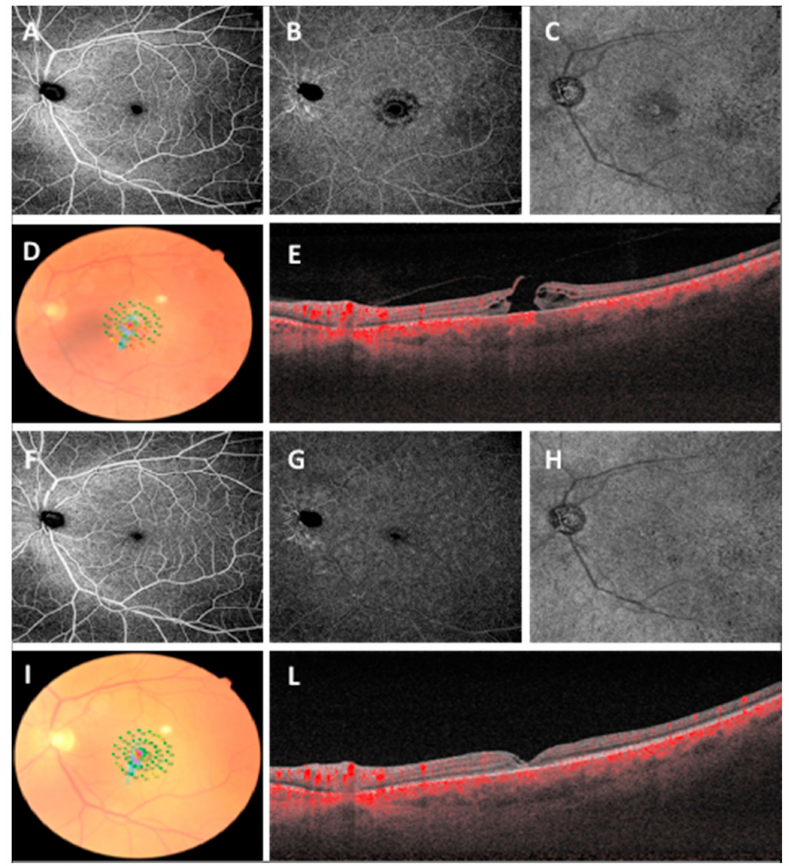
Figure 2. Widefield OCTA scans (12 × 12 mm) of superficial capillary plexus ( A ), deep capillary plexus ( B ), choriocapillaris ( C ), microperimetry ( D ) and OCT scan ( E ) before vitreoretinal surgery in macular hole. Widefield OCTA scans (12 × 12 mm) of superficial capillary plexus ( F ), deep capillary plexus ( G ), choriocapillaris ( H ), microperimetry ( I ) and OCT scan ( L ) at 3-month